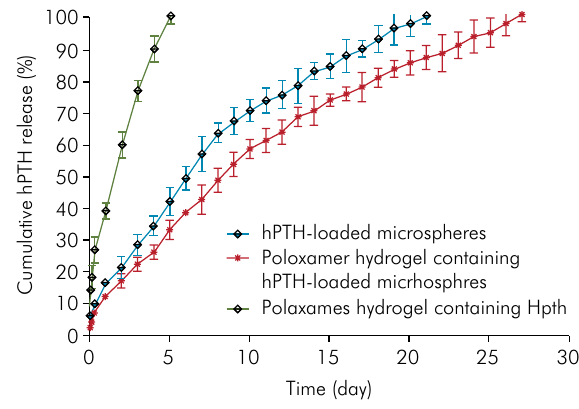
Figure 3. In vitro hPTH release profiles from the microspheres and poloxamer hydrogel formulations (n =